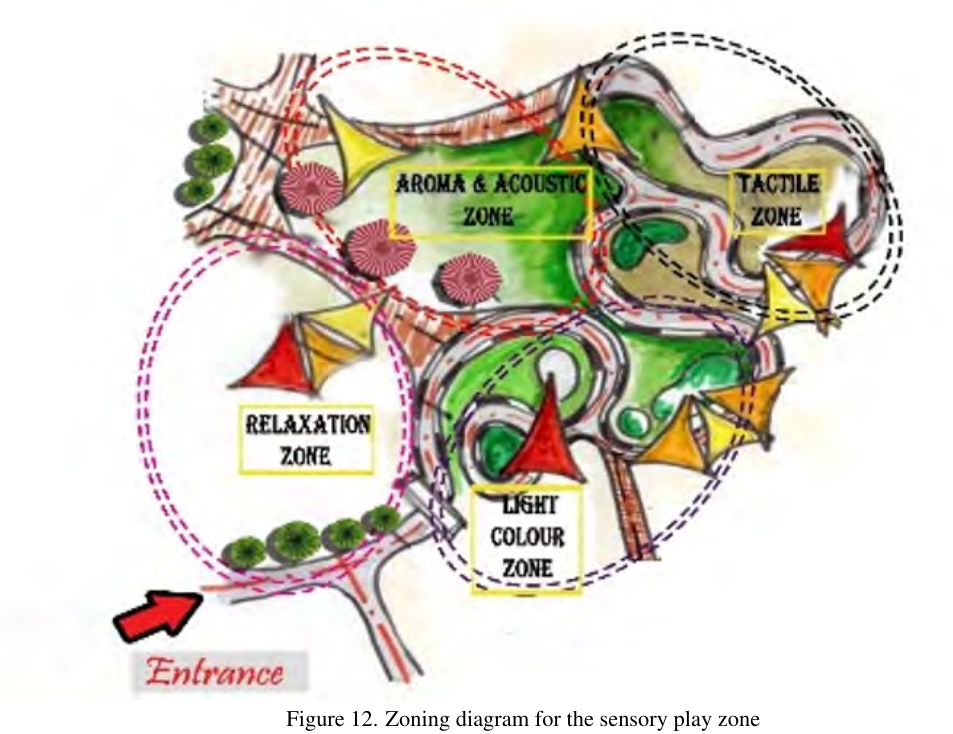
Figure 12. Zoning diagram for the sensory play zone